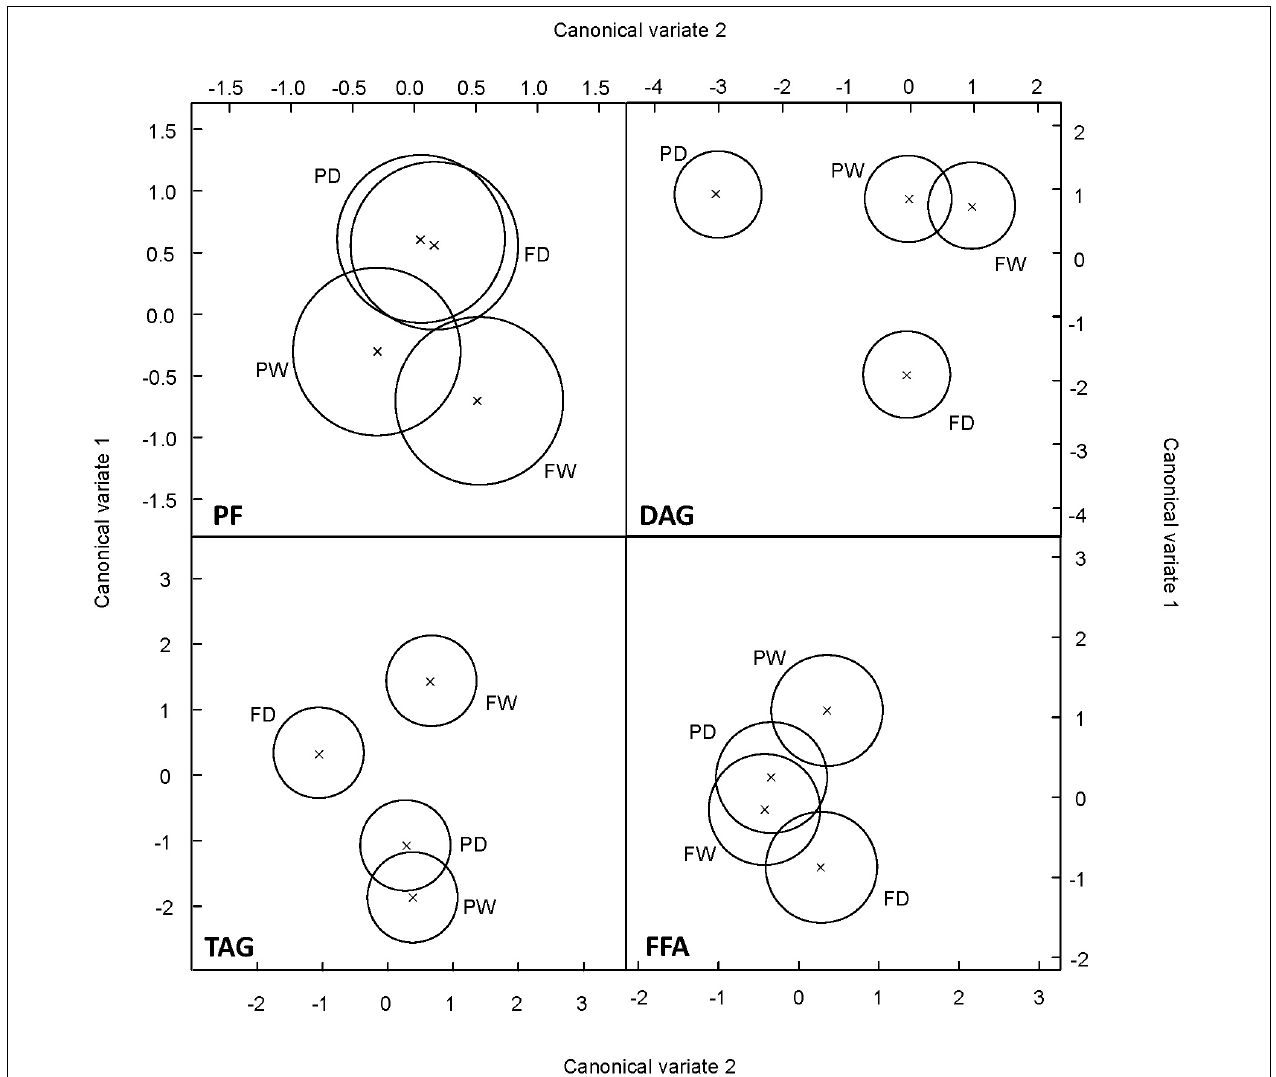
FIGURE 7 | Multivariate analysis of susceptible and resistant oat genotypes according to the different fatty acids assessed. Scatterplot of Canonical variates analysis scores of components 1 and 2 based on the profile of fatty acids within each of the different lipid fractions were performed in drought susceptible Flega and resistant Patones well-watered plants (FW and PW, respectively) and during a time course of water stress (FD and PD, respectively).